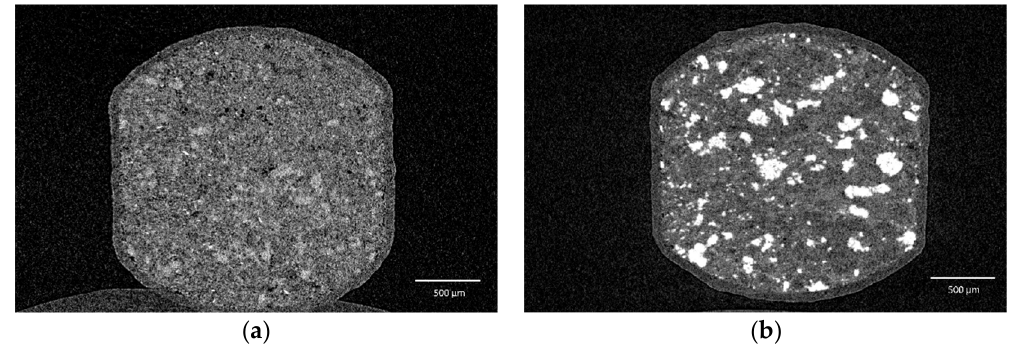
Figure 6. The µCT images of coated mini-tablets of ( a ) F 10C and ( b ) F 11. Figure 6. The µ CT images of coated mini-tablets of ( a ) F 10C and ( b ) F